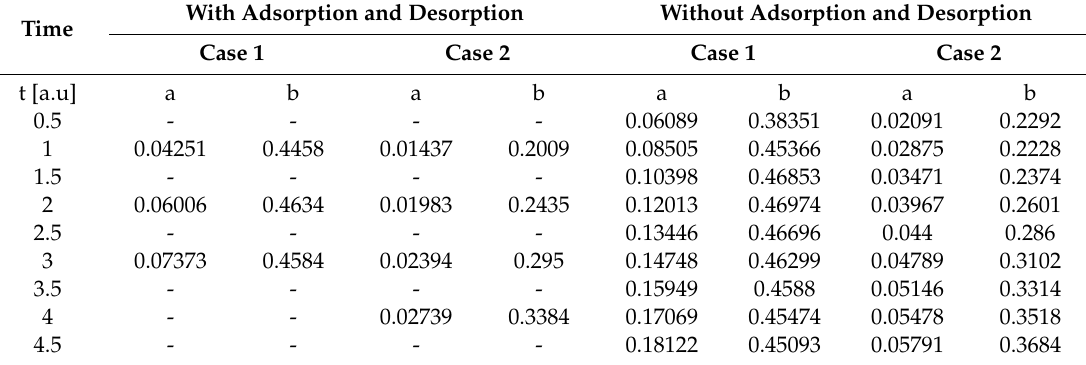
Table 3. Discovered values of a and b coe ffi cients in both Cases 1 and 2 (with and without adsorption /